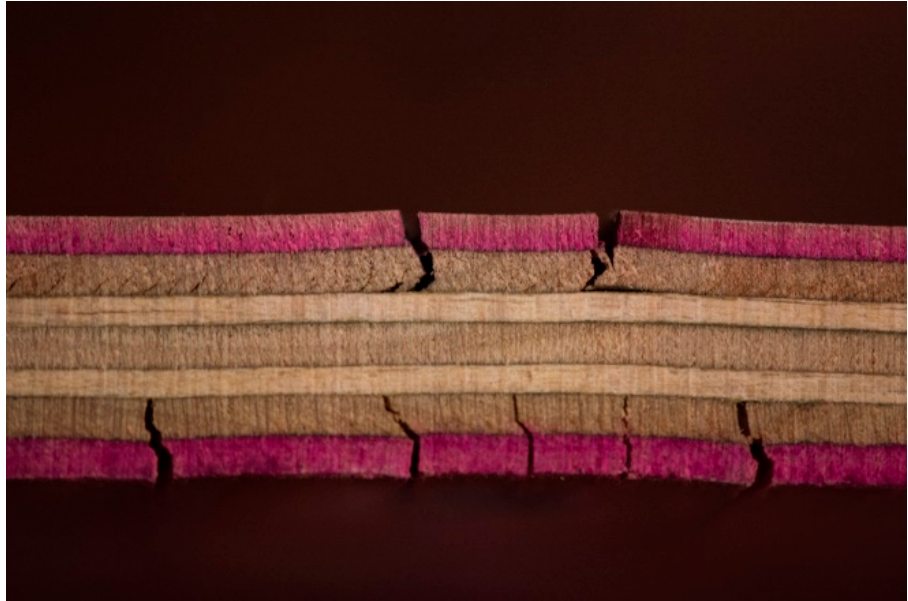
Figure 17. Cross Section View Showing Splitting in Sample 2.